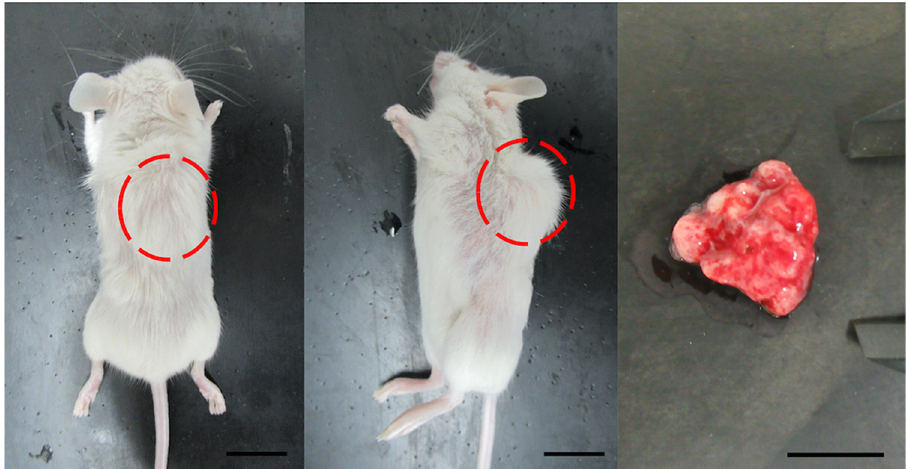
Figure 1. Development of tumors from a cervical cancer xenograft model (PDX71). Left , whole body image from the back. Solid tumor is evident (red circle). Center , whole-body image from lateral view. The tumor consists of a single nodule (red circle). Right , isolated tumor. Scale bar in all images = 10 mm.